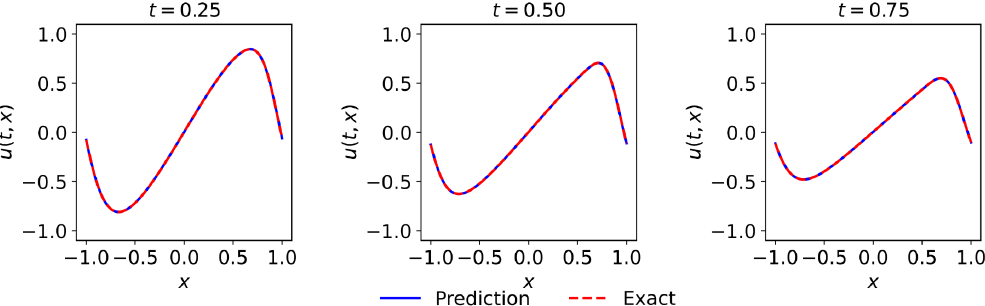
Figure 6. Comparison of the prediction given by physics-informed neural networks with the exact